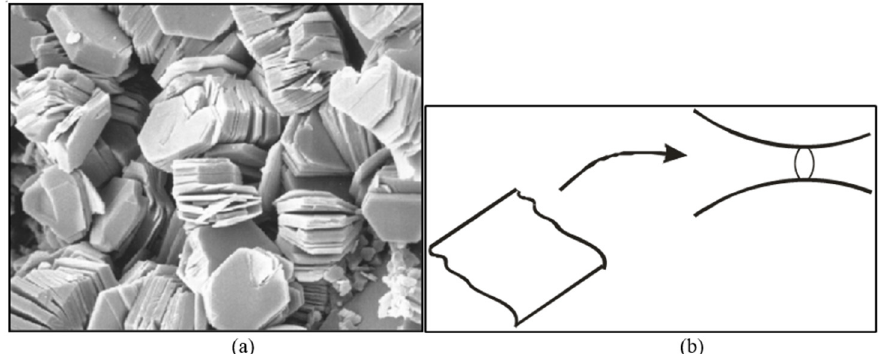
Figure 3. Scanning electron microscope image of clay particles situated on the rock grains: ( a ) kaolinite booklets consist of the platelets stacked to each other by electrostatic forces; ( b ) kaolinite platelet plugs thin pore throat.